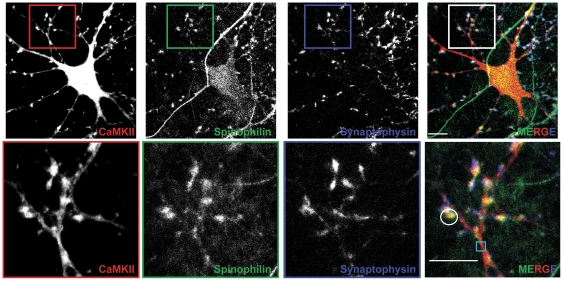
Spinophilin co-localizes with CaMKII in neurons.Confocal images of CaMKII (red), spinophilin (green), and synaptophysin (blue) immunofluorescence. Boxes below show higher magnification of a dendritic section. Scale bars:10 mM.